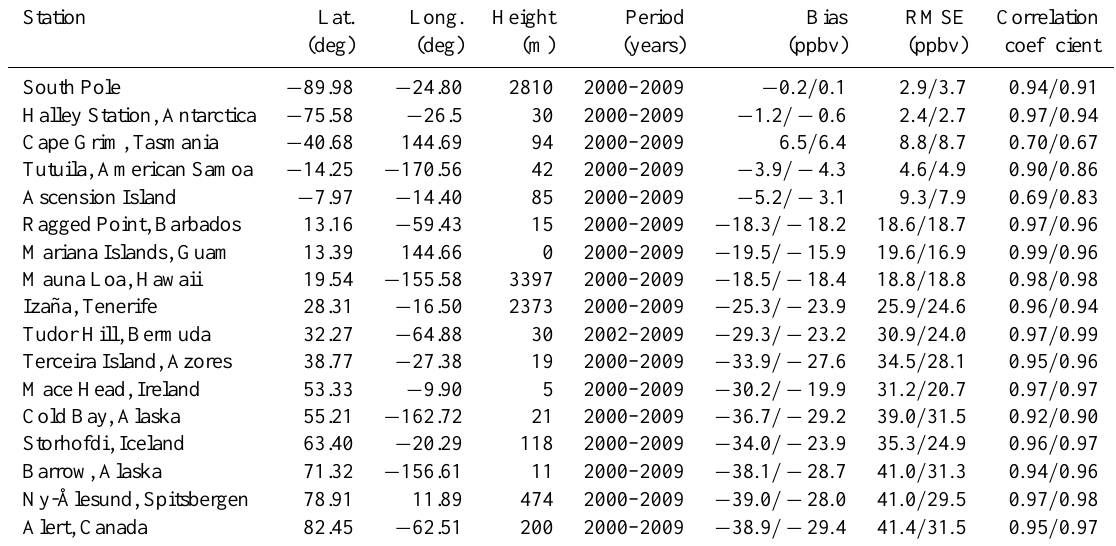
Table A4. List of stations from the NOAA GMD network of flask measurements used for the evaluation of the simulated surface CO mixing ratios. The mean bias and root mean square errors (RMSE) in the simulated monthly mean mixing ratios are indicated for the reference EC-Earth simulation and the corresponding ERA-Interim simulation. Also given are the linear correlation coefficients between the simulated and measured monthly mean concentrations. The results for the EC-Earth and ERA-Interim simulations are separated by a slash.